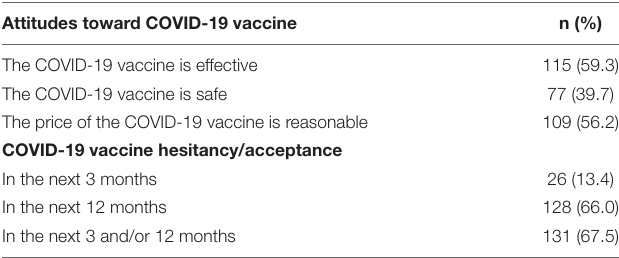
TABLE 2 | Proportion of positive attitudes toward the COVID-19 vaccine and vaccine hesitancy/acceptance at follow-up ( N = 194). Attitudes toward COVID-19